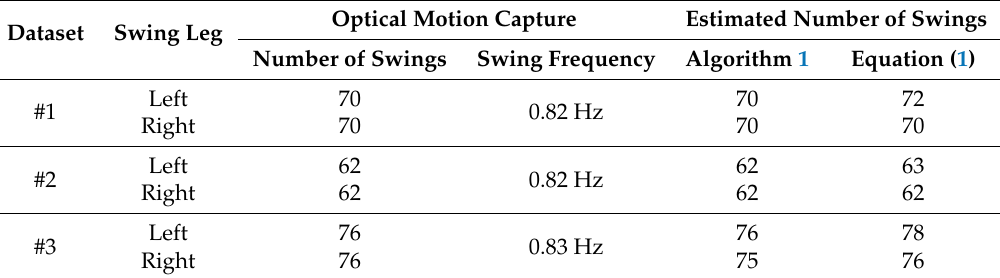
Table 2. Results of swing phase